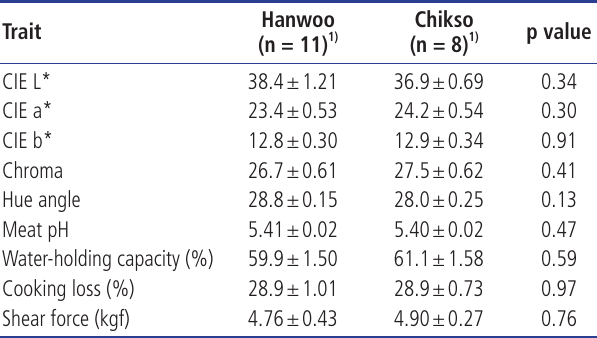
Table 2. Fatty acid composition (%) of strip loin from Hanwoo and Chikso steers finished under same diet